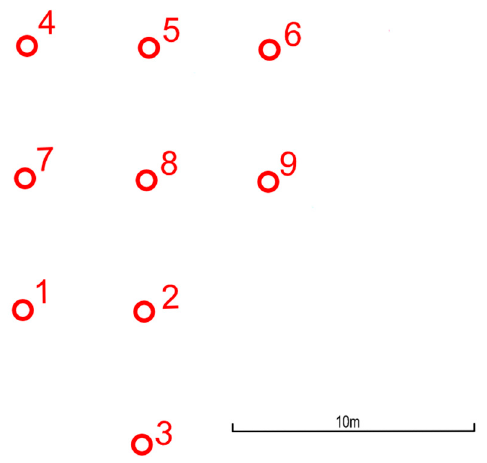
Figure 4. Locations of boreholes in relation to one another.